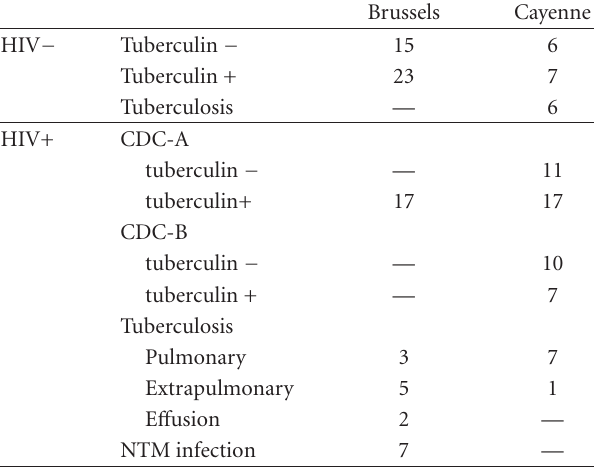
Table 1: Study participants.